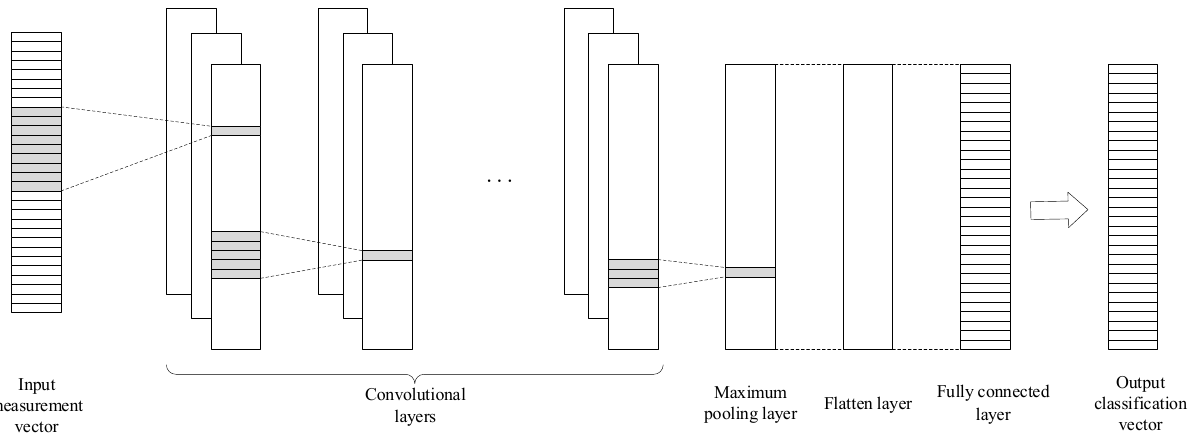
Figure 1. Structure of the proposed CNN.